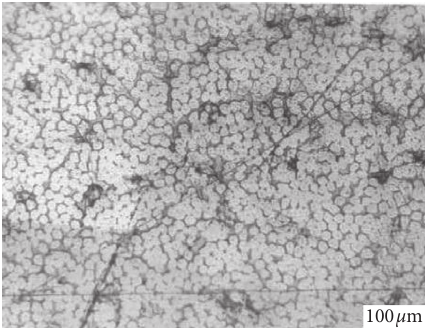
Figure 8: A characteristic photograph of the microsection of the unidirectional fibrous PCM made from oriented epoxy organo- plastic. Magnification 1200.